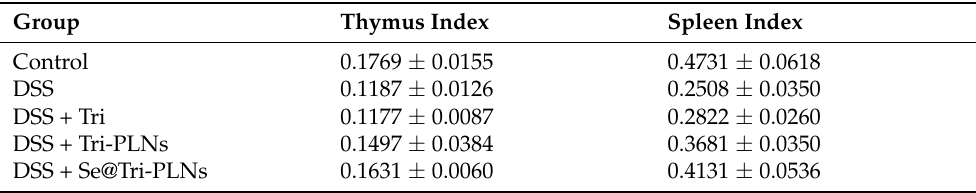
Table 3. Thymus index and spleen index ( n = 5, mean ±